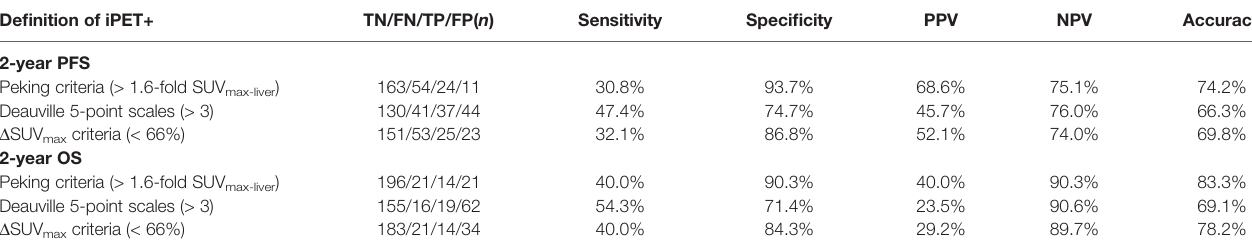
TABLE 2 | Accuracy of interim 18F-FDG PET/CT scan after two cycles of therapy (PET-2) interpreted using different image interpretation methods (n = 252). De fi nition of iPET+